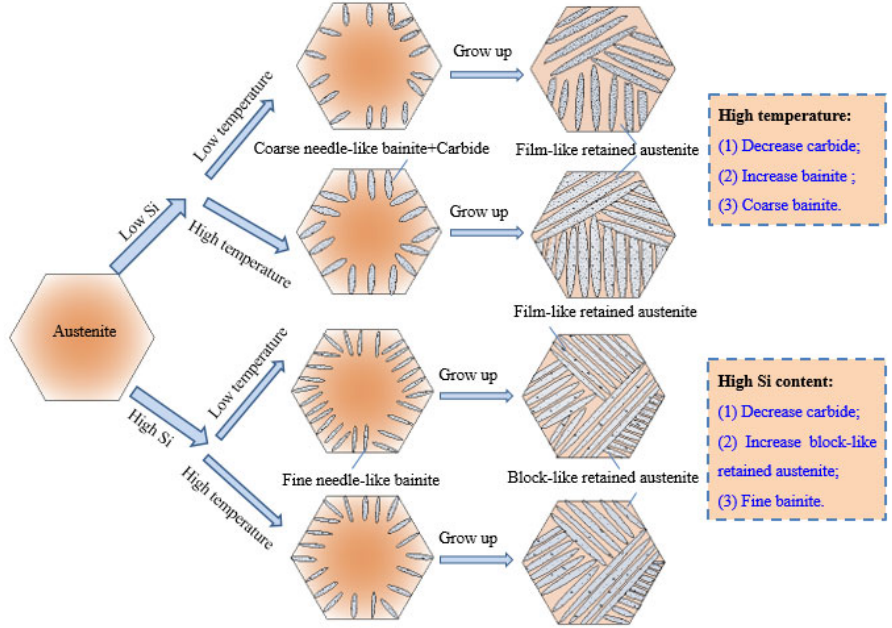
Figure 6. Schematic diagram of the effects of Si and austempered temperature on bainite transformation, carbides and block-like retained austenite formation.